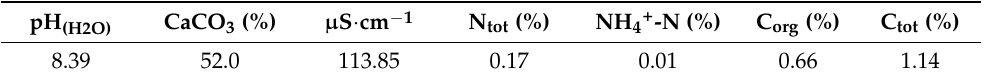
Table 2. The chemical properties of calcareous